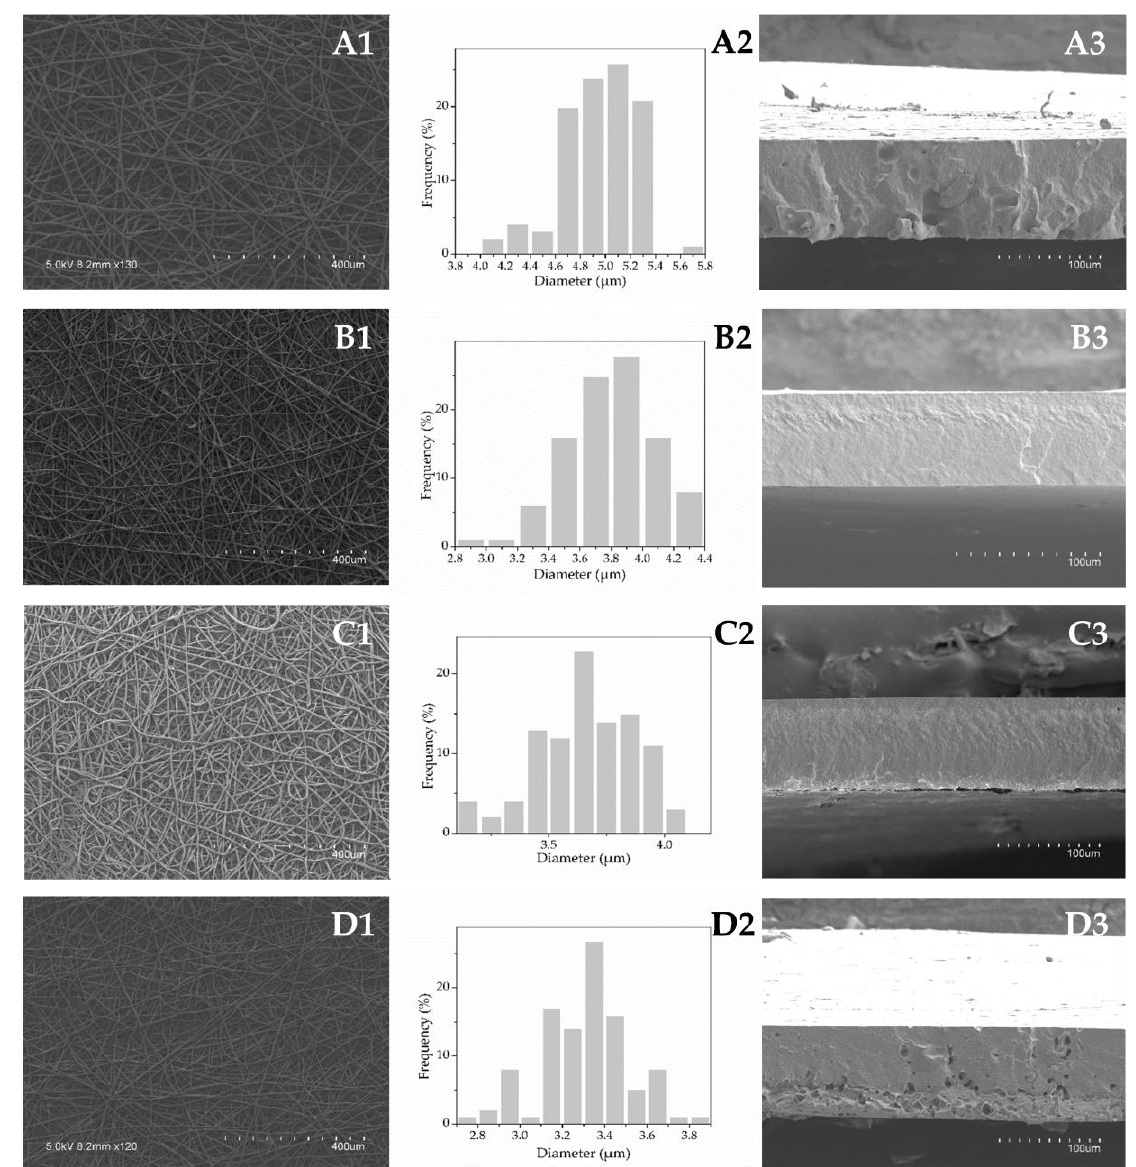
Figure 1. Scanning electron microscopy (SEM) micrographs of the electrospun fibers (A1-D1, vertically), diameter distribution histograms (A2–D2, vertically) and cross-sections of the annealed films (A3–D3, vertically) of the plain poly( ε -caprolactone) PCL (A1–3) and the formulations containing 5% (B1–3), 10% (C1–3), and 20% (D1–3) of